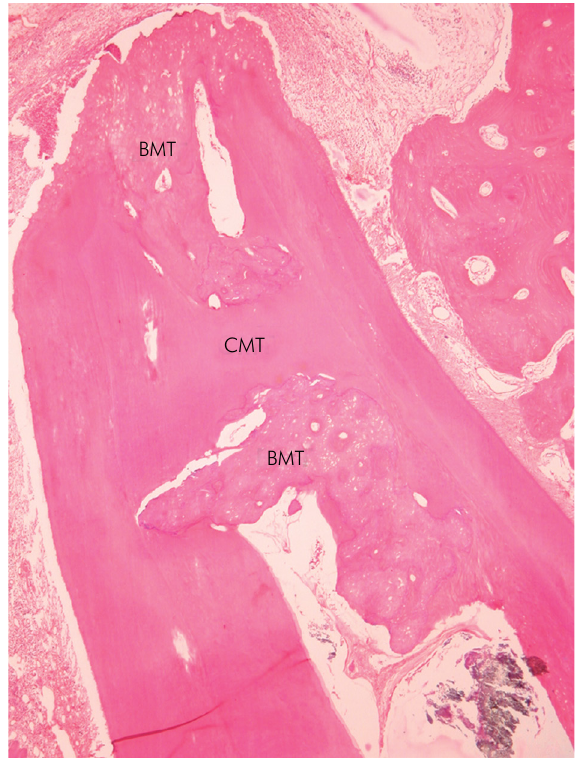
Figure 5. Photomicrograph of a specimen from the propolis paste group showing bone-like mineralized tissue (BMT) in contact with cementum-like mineralized tissue (CMT). 20×